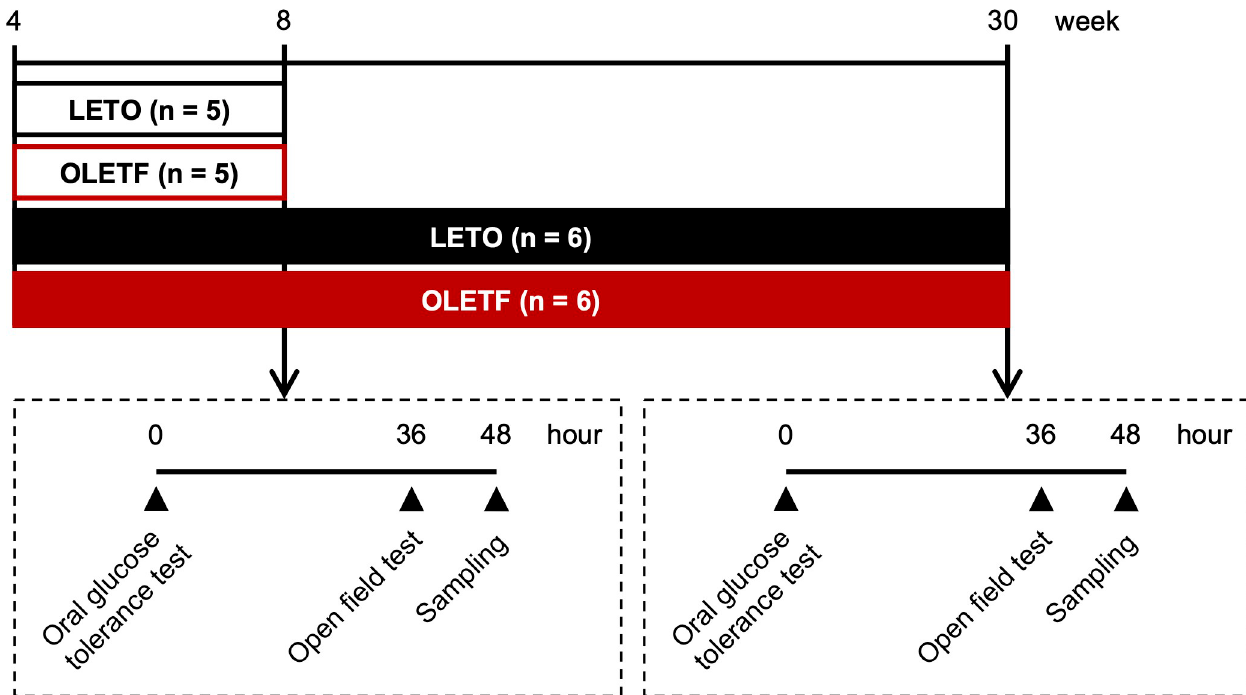
Fig 1. Experimental timeline. Male LETO and OLETF rats were housed and given free access to food and water. At the age of 8 or 30 weeks, an oral glucose tolerance test was conducted. After 36 h, an open-field test was performed. At 12 h after the open-field test, the brain samples were collected.